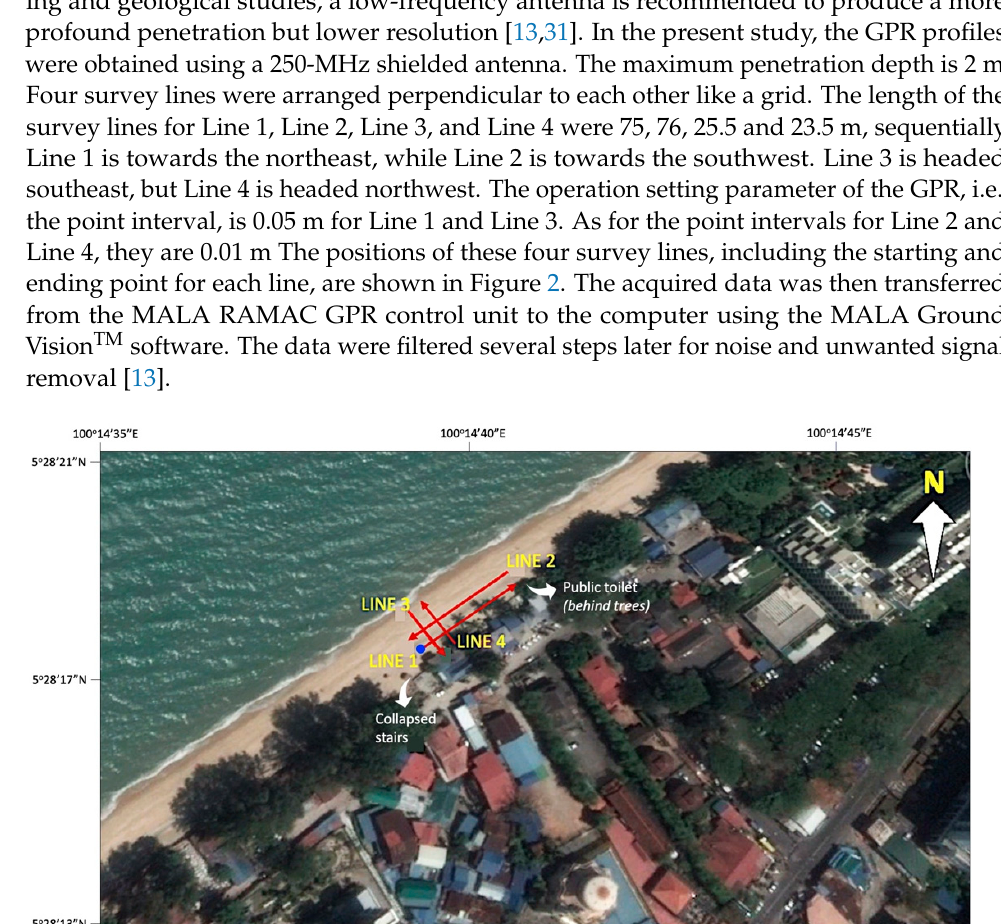
Figure 3. Survey lines of GPR at site 2, Persiaran Bayan Indah, Bayan Lepas representing anthropo- genic coastal landform, plotted on Google Earth (2015), Persiaran Bayan Indah, Penang, Malaysia. The coordinates for the initial point of survey lines ( • ) is 05°19 ′ 57.19 ″ N and 100°18 ′ 30.23 ″ E. Digital- Globe 2015. http://earth.google.com (accessed on 3 February 2015). Five sediment samples were collected from the Batu Ferringhi site, then another five were collected from the Queensbay Mall parking lot site. The raw data of these ten sedi- ment samples can be accessed online (open access) from https://doi.org/10.5281/ze- nodo.4395755, accessed on 11 April 2021. In the laboratory, the samples were placed in a beaker and washed with water. The samples were stirred using a spatula, and these steps were repeated a few times until it became apparent few impurities remained. The water was then removed. In the next step,